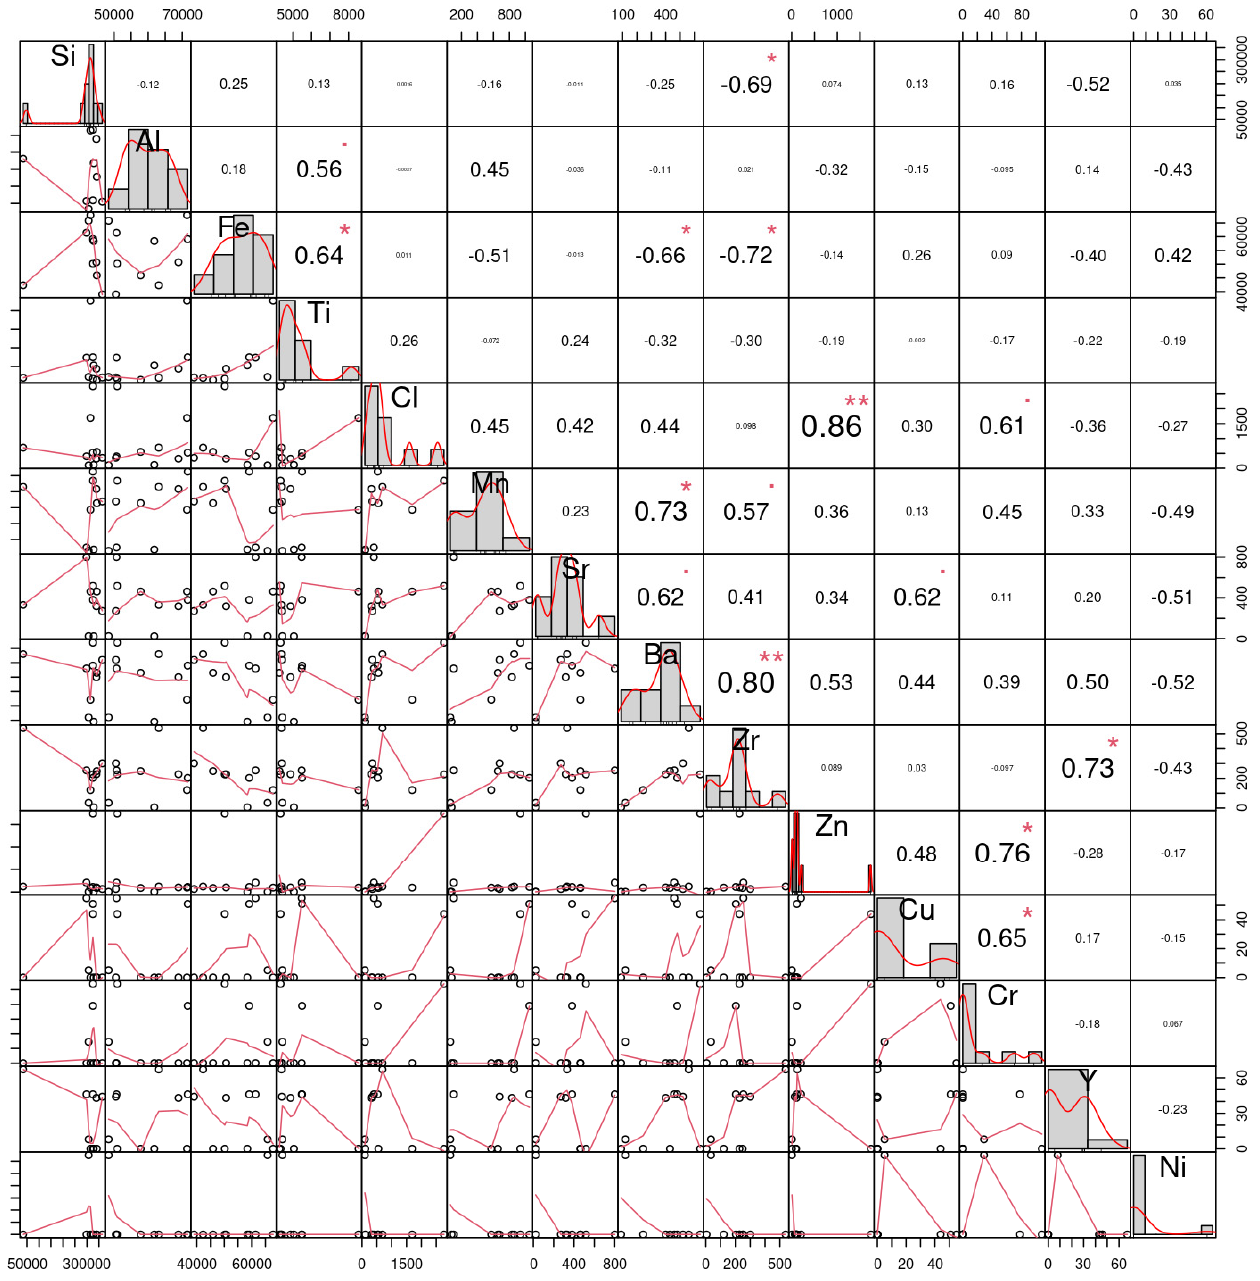
Figure 5. The correlation matrix of the 14 microelement’s readings obtained from the studied Taif rose farms for prediction of the concentration of an element based on the concentrations of other elements. the signal asterisk (*) indicate the correlation is significant at the 0.05 level and double asterisk (**) indicate indicates the correlation is significant at the 0.01 level.